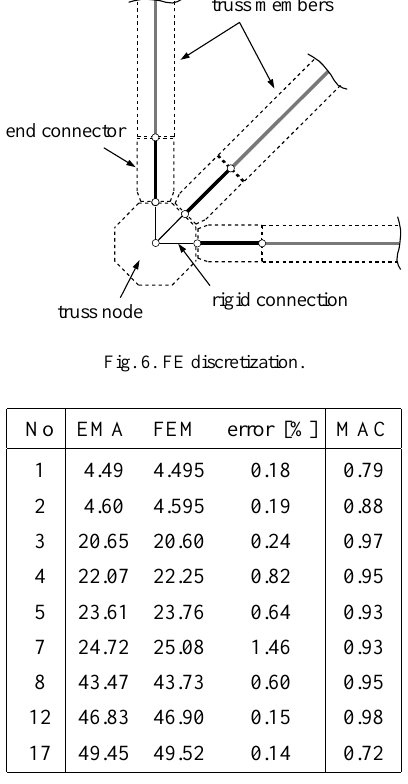
Fig. 7. Eigenfrequencies in